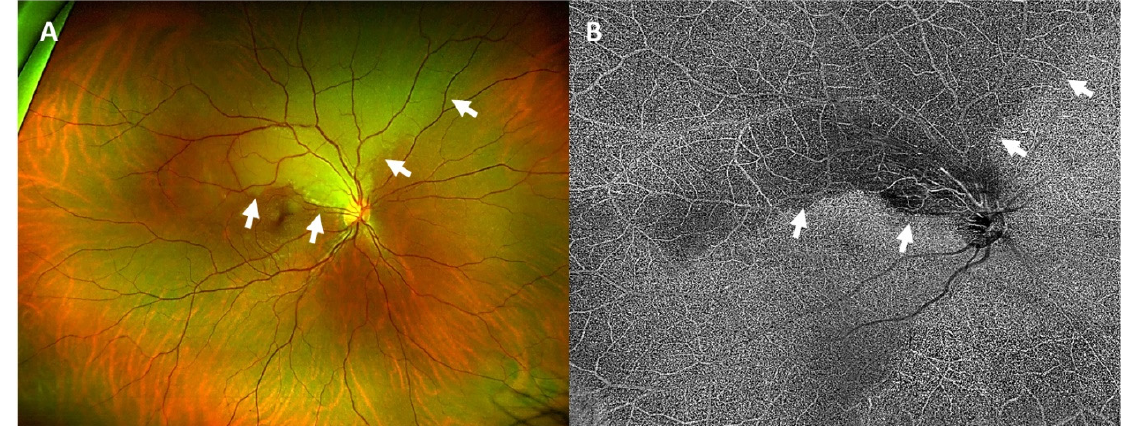
Figure 1. Wide-angle fundus photography of the right eye ( A ) showed a pale, edematous area corresponding to the area of arterial occlusion (white arrows). In optical coherence tomography angiography ( B ) the area of arterial occlusion was seen as a hypoautofluorescent area with a missing blood supply (white arrows).